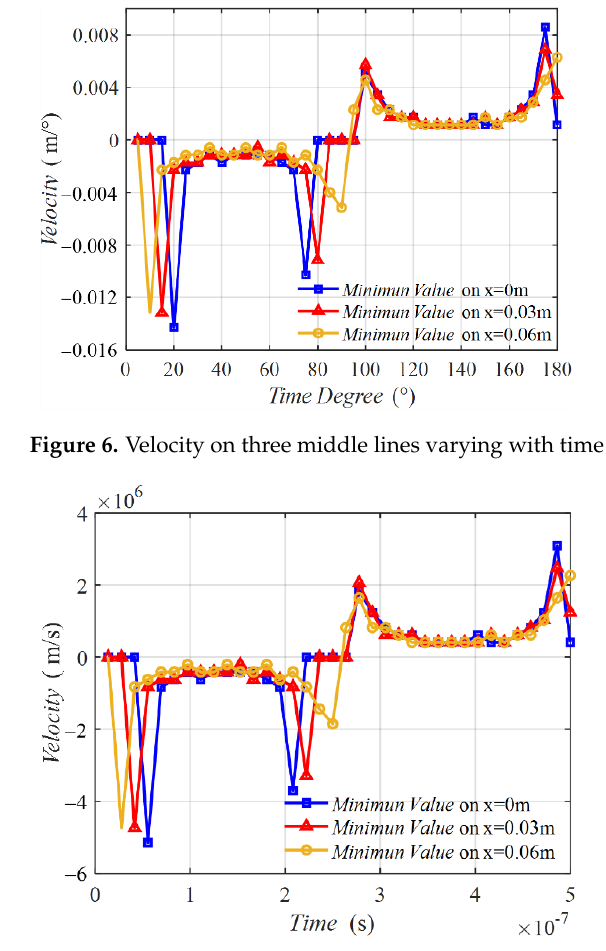
Figure 7. Velocity on three middle lines varying with time.